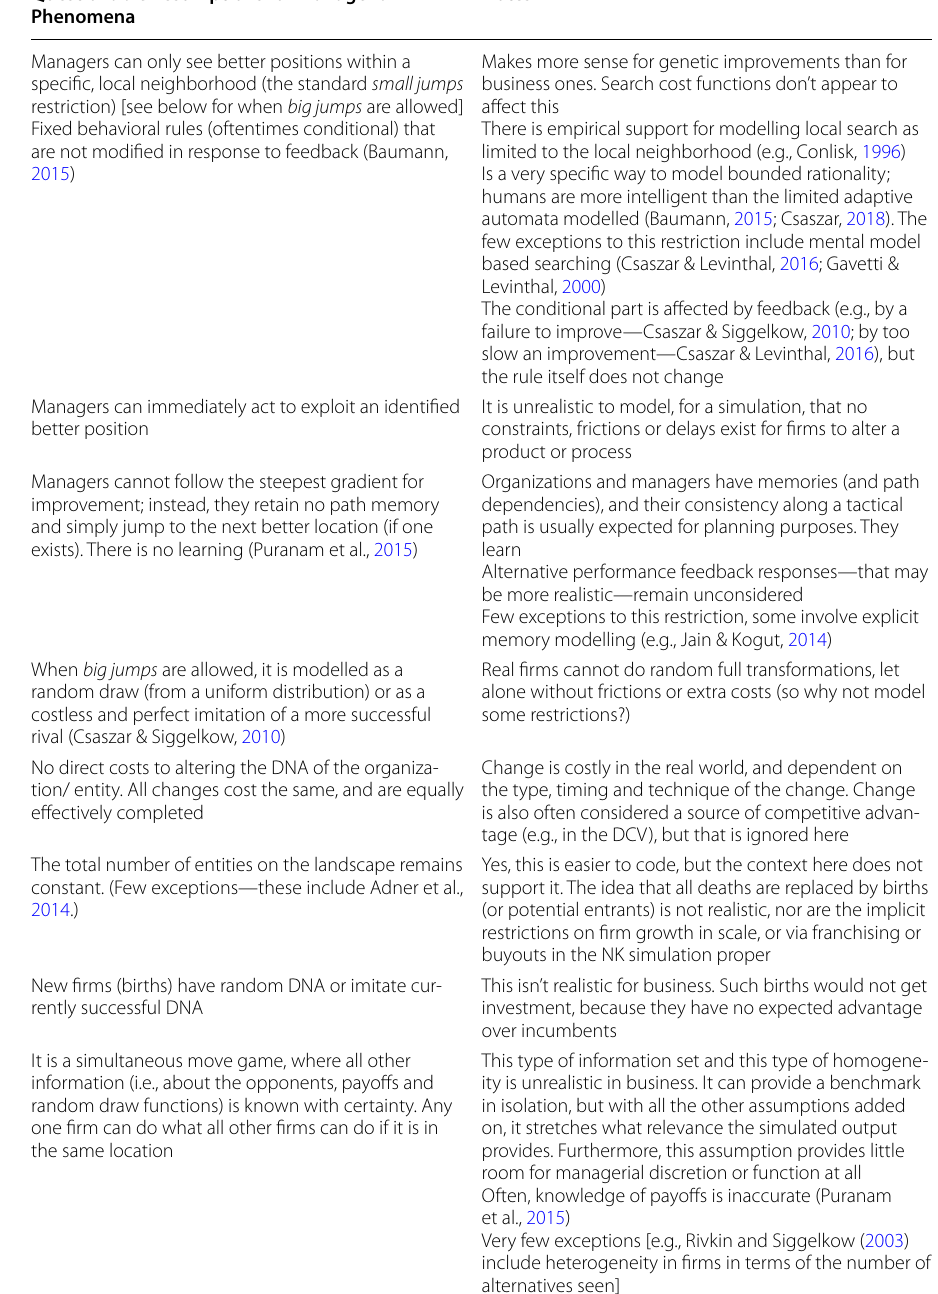
Table 1 Analysis of inappropriate NK